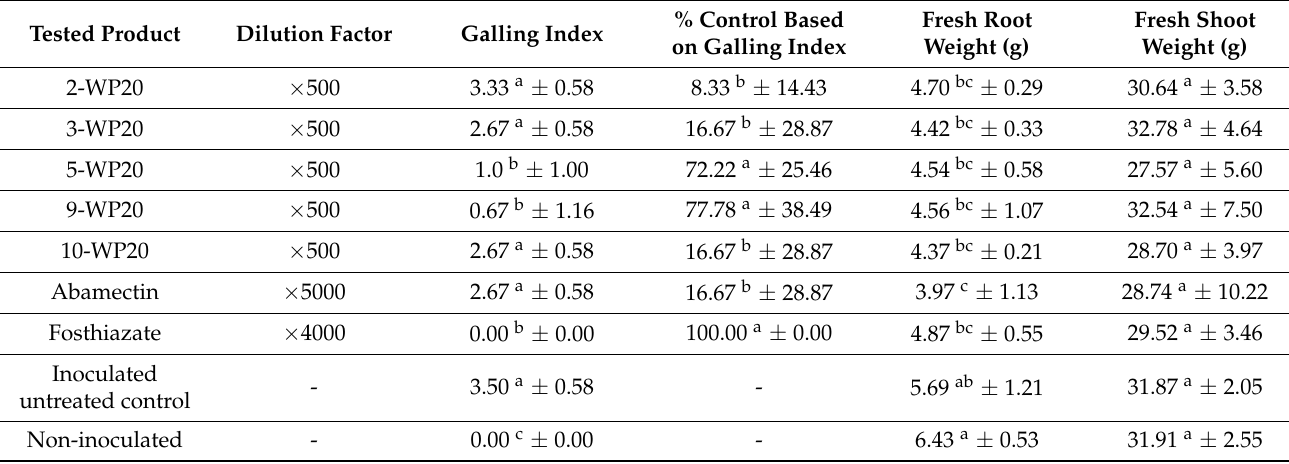
Table 2. Efficacy of wettable powder formulations of 2,5-dihydroxybenzaldehyde ( 2 -WP20), m -cresol ( 3 -WP20), toluquinol ( 5 -WP20), grammicin ( 9 -WP20), and 2,4-dihydroxybenzaldehyde ( 10 -WP20) in the controlling of Meloidogyne incognita on tomato plants.